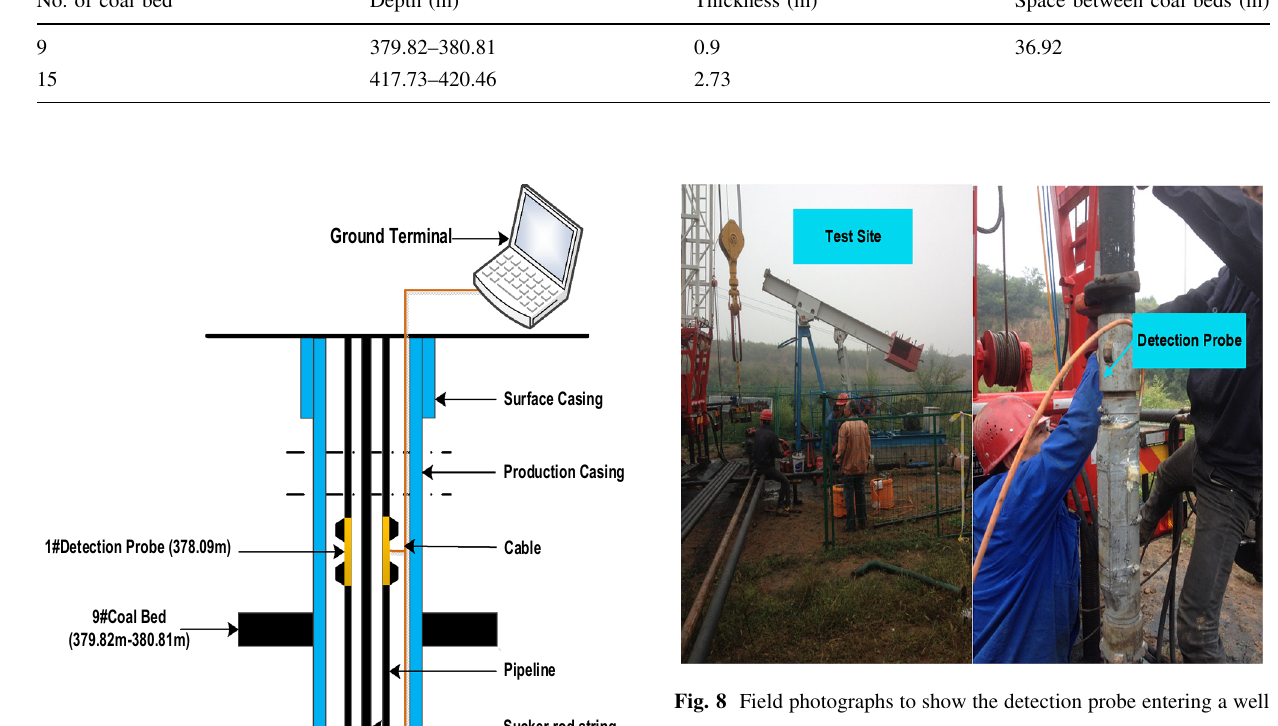
Table 3 Burial depths and spacing of 9#coal bed and 15#coal bed No. of coal bed